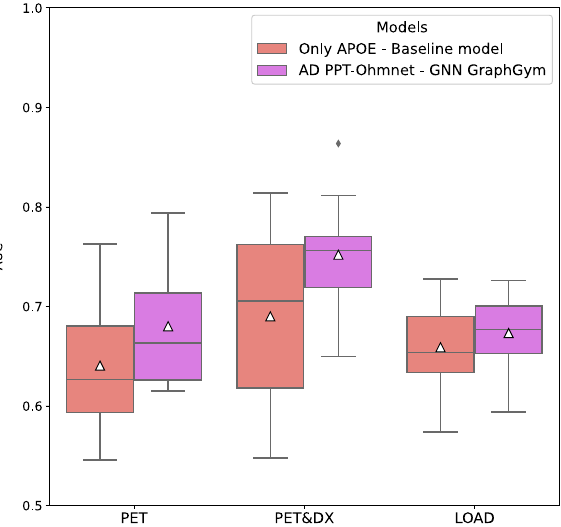
Figure 5. Boxplots showing the AUC distribution values of baseline and GNN models on the test sets using as targets either PET&DX, PET from the ADNI cohort, or LOAD from the TGenII cohort. White triangles represent mean AUC